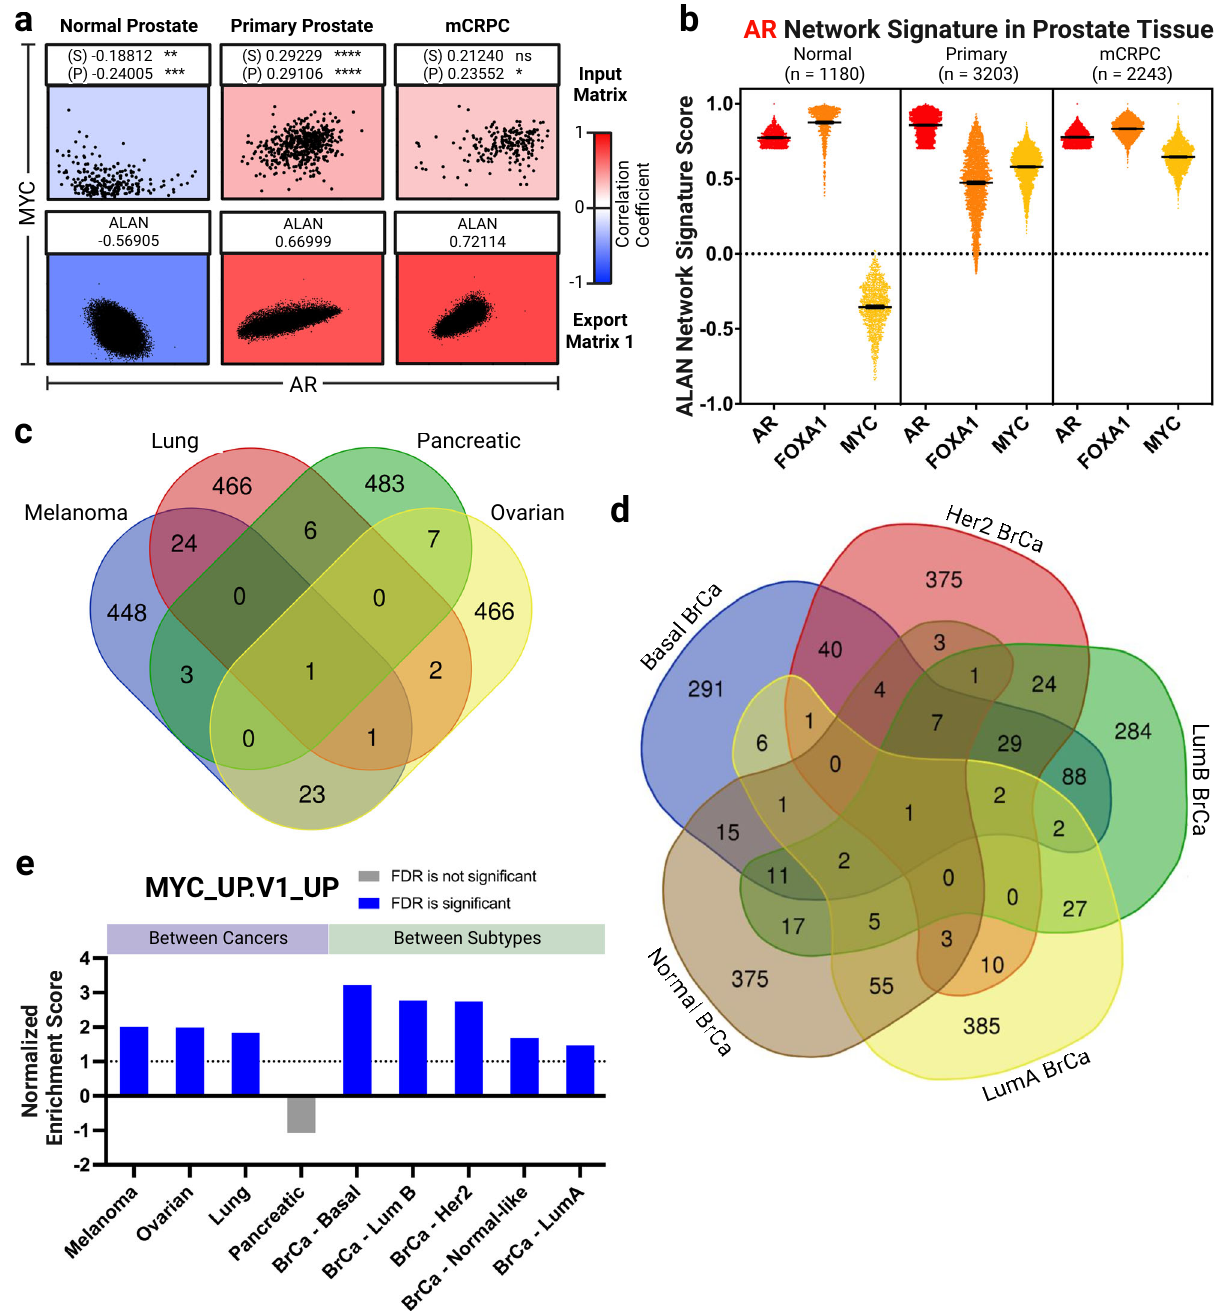
Fig. 3 ALAN identi fi es context-speci fi c gene behavior across prostate tissues, across different cancer types, and within cancer subtypes. a The correlation between AR and MYC is depicted from blue (-1) to red ( + 1) in normal prostate tissue, primary prostate tissue, and mCRPC. Input matrix data was used for the top three visuals where each dot is a patient and its x- and y- coordinates represent the gene expression of AR or MYC , respectively. ALAN Output - Matrix 1 was used for the bottom three visuals where each dot represents an individual gene and its x- and y- coordinates represent the ALAN pro fi le correlations with either AR or MYC , respectively. The numerical ALAN value between AR and MYC was obtained from ALAN Output – Matrix 2. b The ALAN pro fi le correlation value is plotted for each gene within the ALAN AR network signature for the ALAN networks of AR (red), FOXA1 (orange), and MYC (yellow). Individual genes in the indicated signature are compared in normal, primary, and mCRPC where the number of genes in each signature is indicated (n) and error bars represent mean with 95% con fi dence interval of the ALAN network signature score. c The overlap between MYC ALAN network signatures across four distinct cancer types in TCGA (Melanoma, Lung, Pancreatic and Ovarian) are visualized using a Venn diagram. d The overlap between MYC ALAN network signatures across fi ve subtypes of breast cancer (Basal, Her2, LumA, LumB, and Normal) are visualized using a Venn diagram. e GSEA enrichment analysis with NES and FDR statistics of the MYC_UP.V1_UP gene set and the MYC ALAN Network from four distinct cancer types (Melanoma, Lung, Pancreatic and Ovarian) and fi ve subtypes of breast cancer (Basal, Her2, LumA, LumB, Normal-like) from